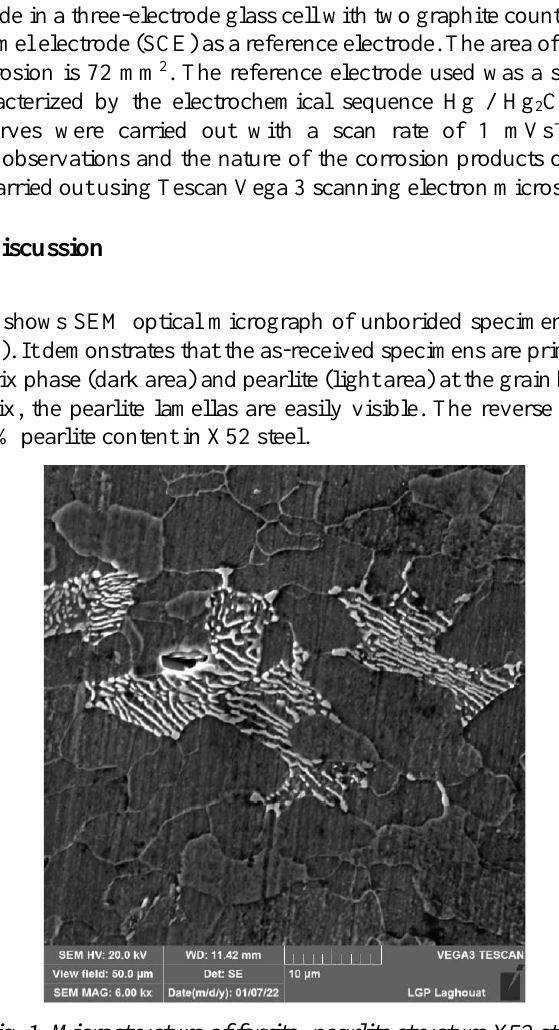
Fig. 1. Microstructure of ferrite -pearlite structure X52